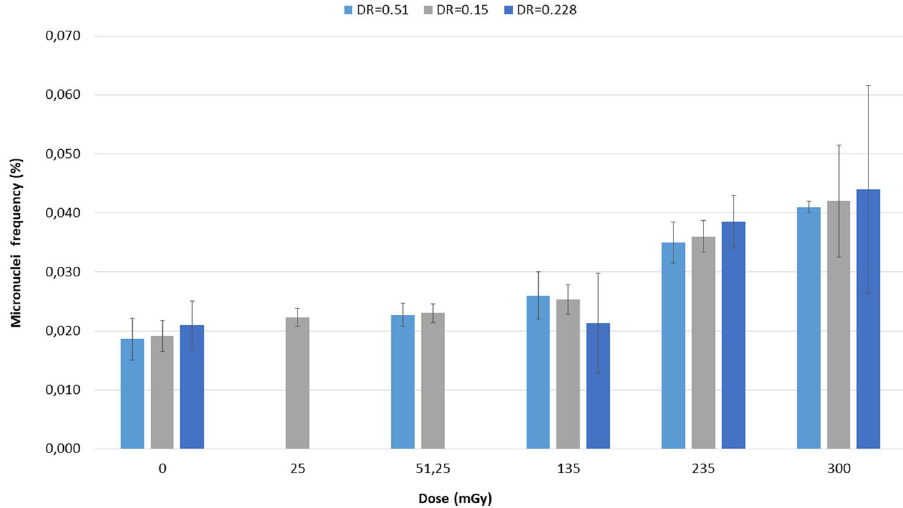
Figure 11. Frequencies of micronuclei (MN) in BNC. Dose rate (DR) is expressed in Gy/min.